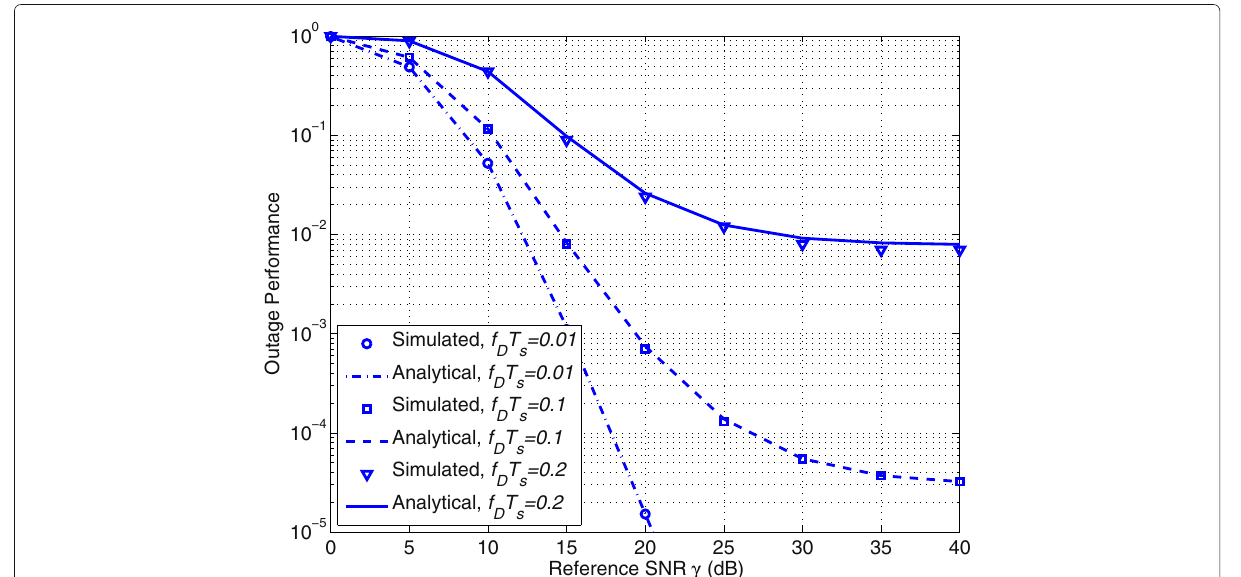
Fig. 5 Outage probability for systems with different maximum normalized Doppler spreads ( N = 4 and x = 200)